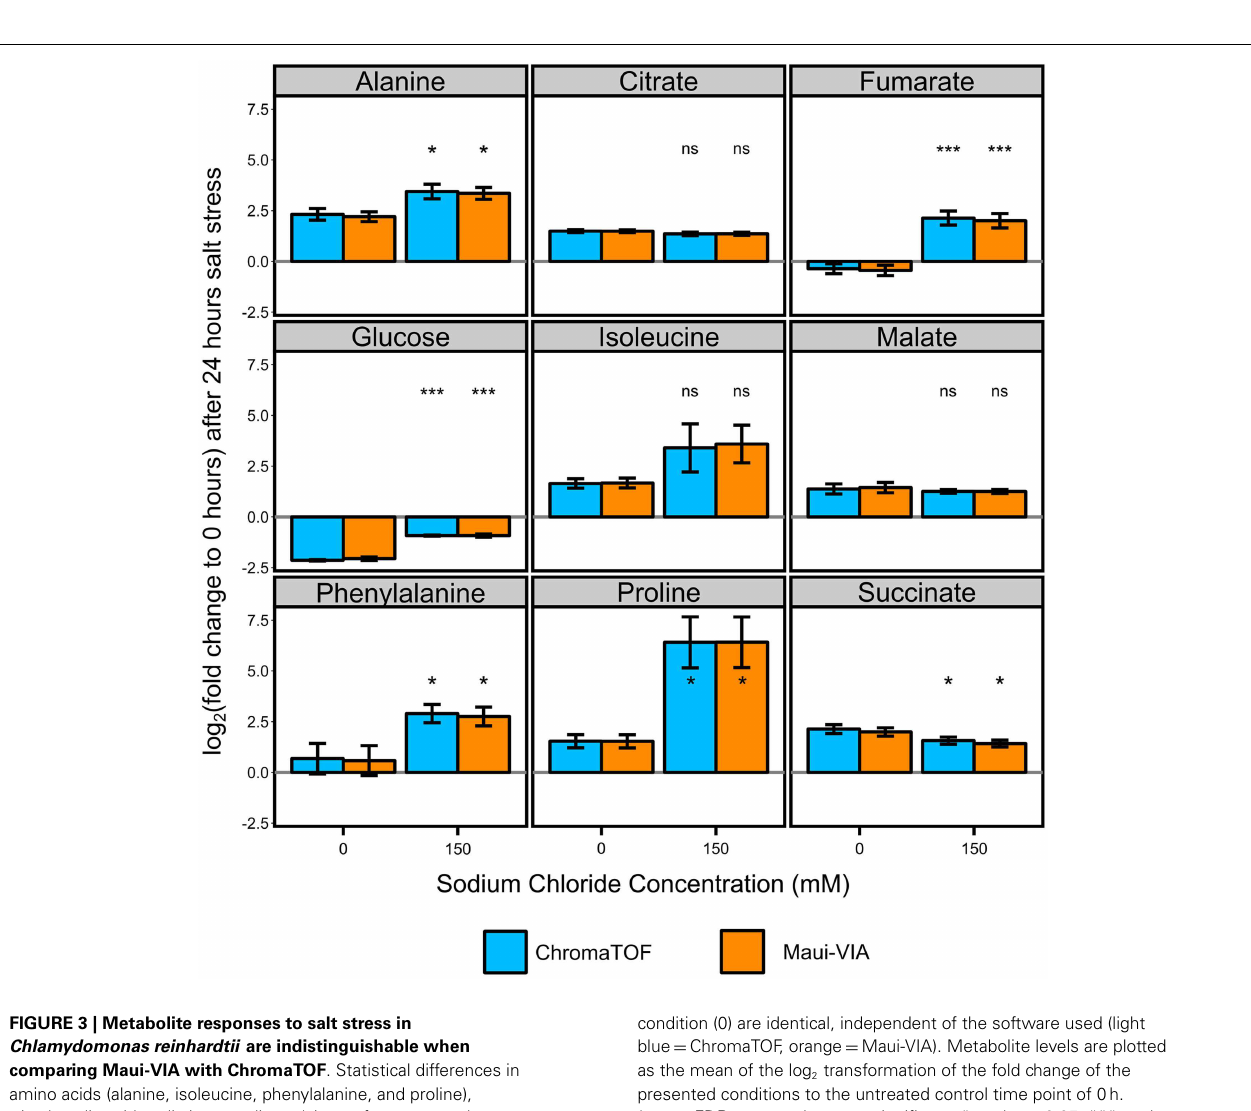
FIGURE 3 | Metabolite responses to salt stress in Chlamydomonas reinhardtii are indistinguishable when comparing Maui-VIA with ChromaTOF . Statistical differences in amino acids (alanine, isoleucine, phenylalanine, and proline), tricarboxylic acid cyclic intermediates (citrate, fumarate, malate, succinate), and glucose between the salt stress (150) and control